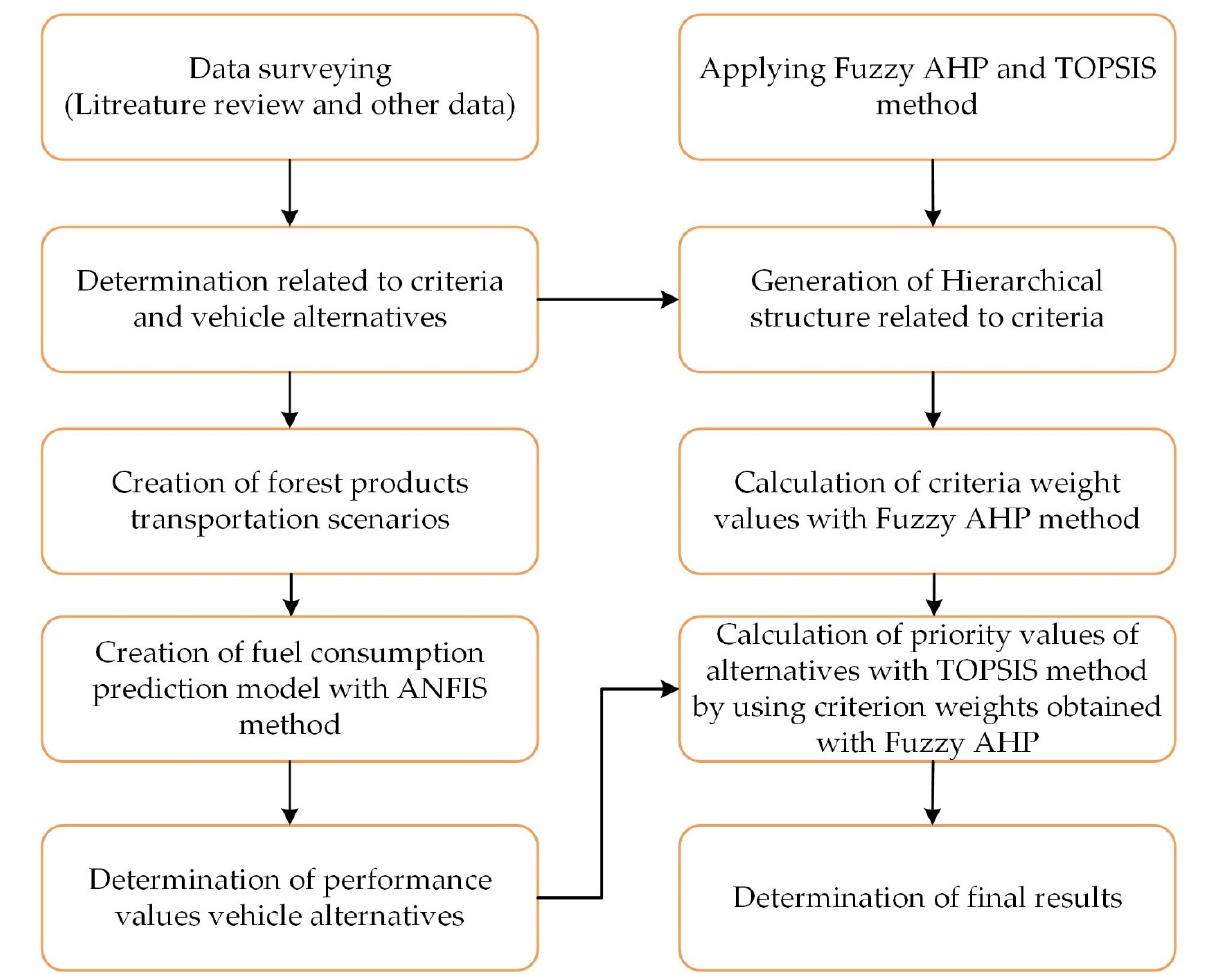
Figure 3. The flowchart of proposed for hybrid fuzzy multi criteria decision system .